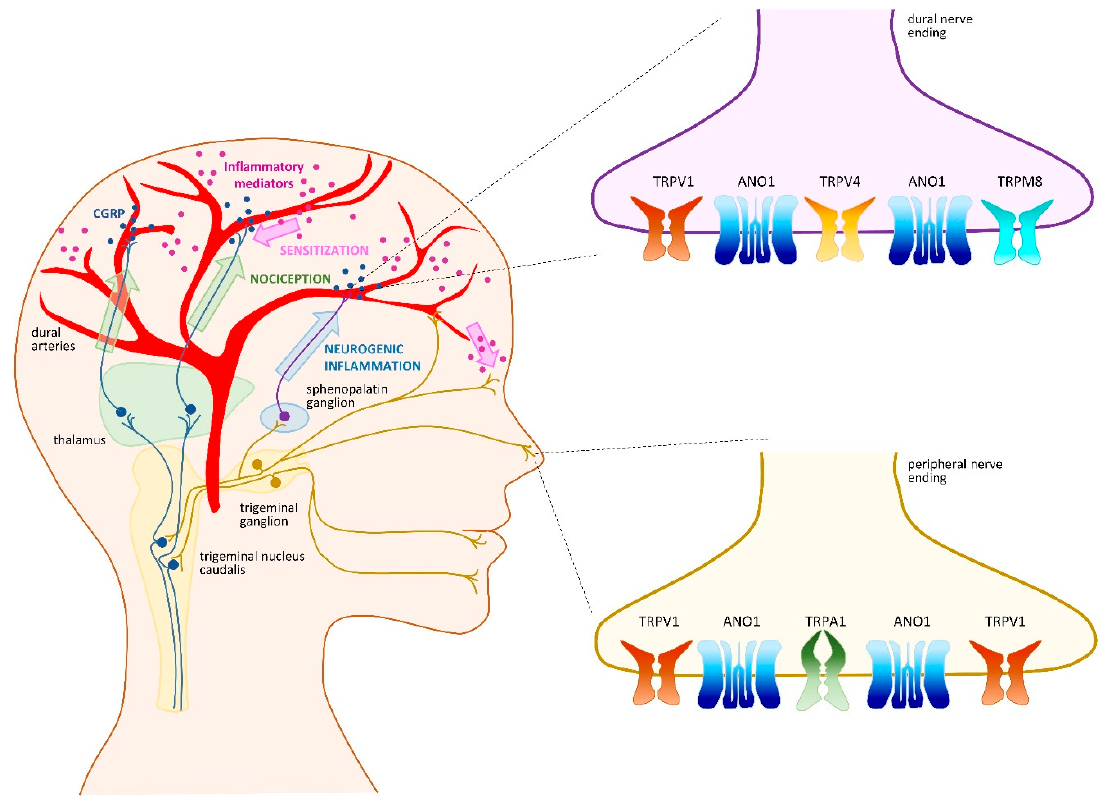
Figure 2. Transient receptor potential (TRP) channels in the trigeminovascular system and migraine development. Migraine triggering events remain unknown and may be a central or peripheral